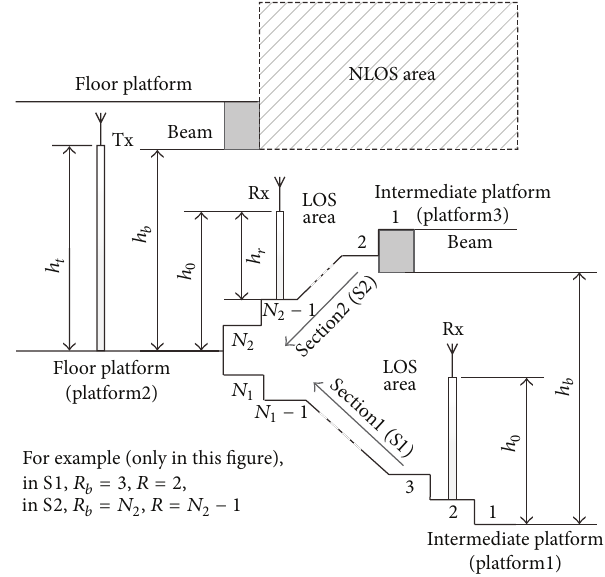
Figure 1: Typical stair